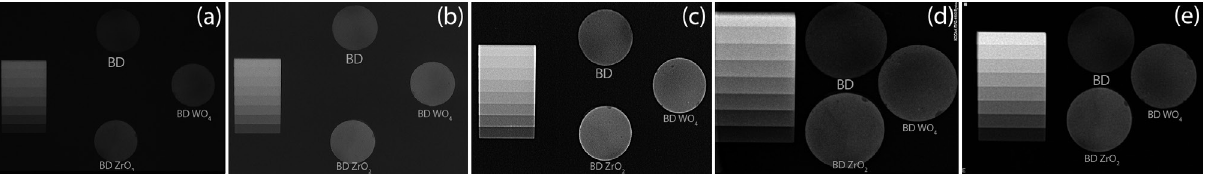
Figure 2- Radiography images obtained with different systems showing the specimens of the materials alongside the aluminum step wedge. (a) occlusal film digitized with a photographic camera; (b) occlusal film digitized with a radiograph scan; (c) photostimulable phosphor plate; (d) Kodak digital sensor; and (e) Fona digital sensor. BD=Biodentine; BD ZrO Oxide; BD Table 2- Mean and standard deviation of pH values of the materials and control in the evaluated time intervals